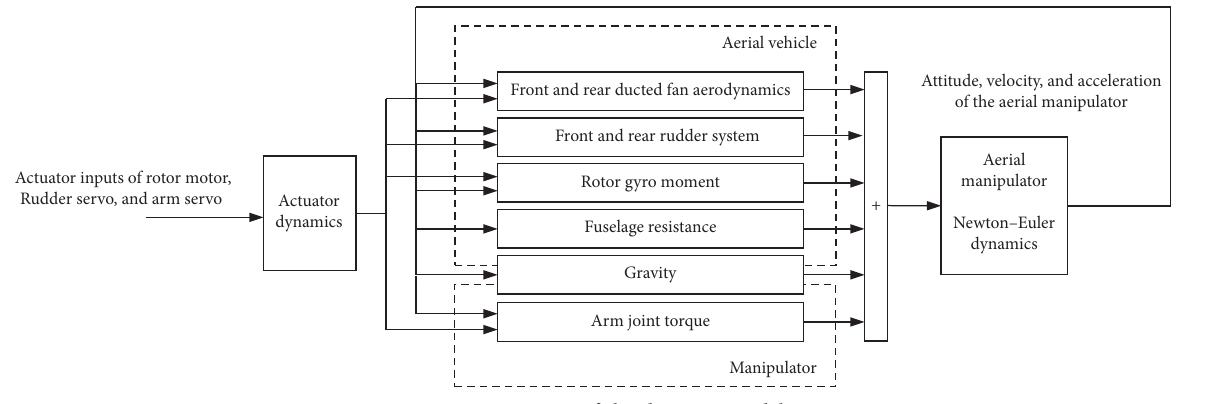
Figure 6: Diagram of the dynamic